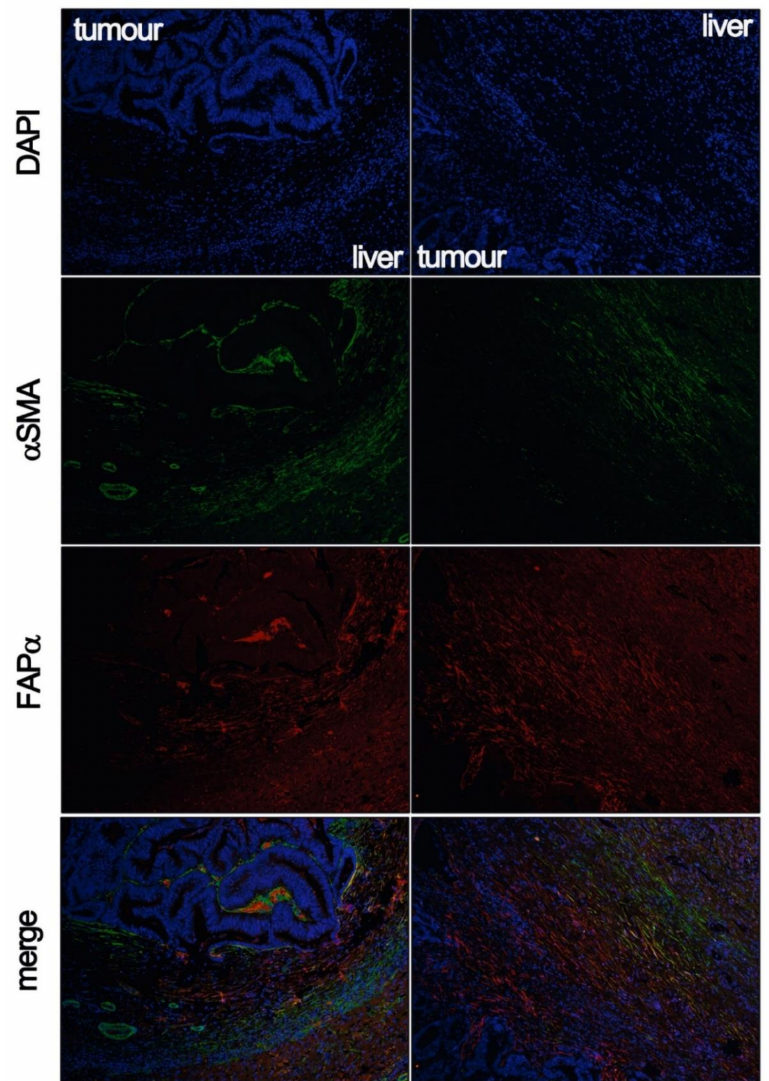
Figure 3. The fibrous capsules of liver metastases present CAFs that express different biomarkers classically associated with the activation of these cells. This fact enables two hypotheses, pending to be proved. On the one hand, it could be that different subpopulations coexisted in the same peritumoral area. On the other hand, it could be the same cells, which, depending on their proximity to the tumor cells, could establish a paracrine crosstalk with them, which would modulate the phenotype of the CAFs. The two columns of images correspond to two different encapsulating tumors, where positive α SMA CAFs (green immunofluorescence) are observed in the outer area of the capsule, the one closest to the liver parenchyma. On the contrary, in the inner area, α SMA positivity progressively disappears, while FAP-expressing cells (red immunofluorescence) appear as fibroblasts approach tumor cells. The FAP protein has two main locations, as a protein anchored to the plasma membrane, or as a component of the extracellular matrix (ECM). In some publications, it has been mentioned that fibrous capsules are formed by fibroblasts on their outermost layer and by acellular components on their innermost layer, mainly ECM components. However, DAPI staining indicates the presence of elongated nuclei that are compatible with the existence of CAFs in the deeper areas of the fibrous